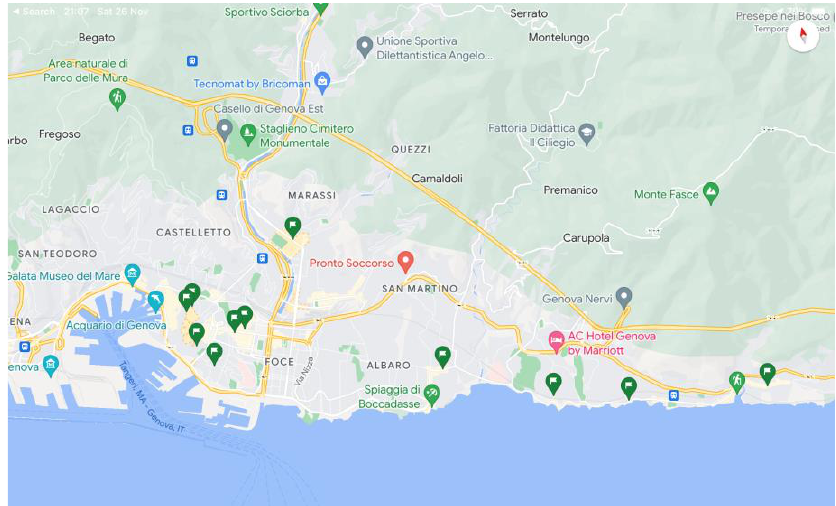
Figure 2. Localisation of the respondents (flagged in green) based on Google Map cartography.